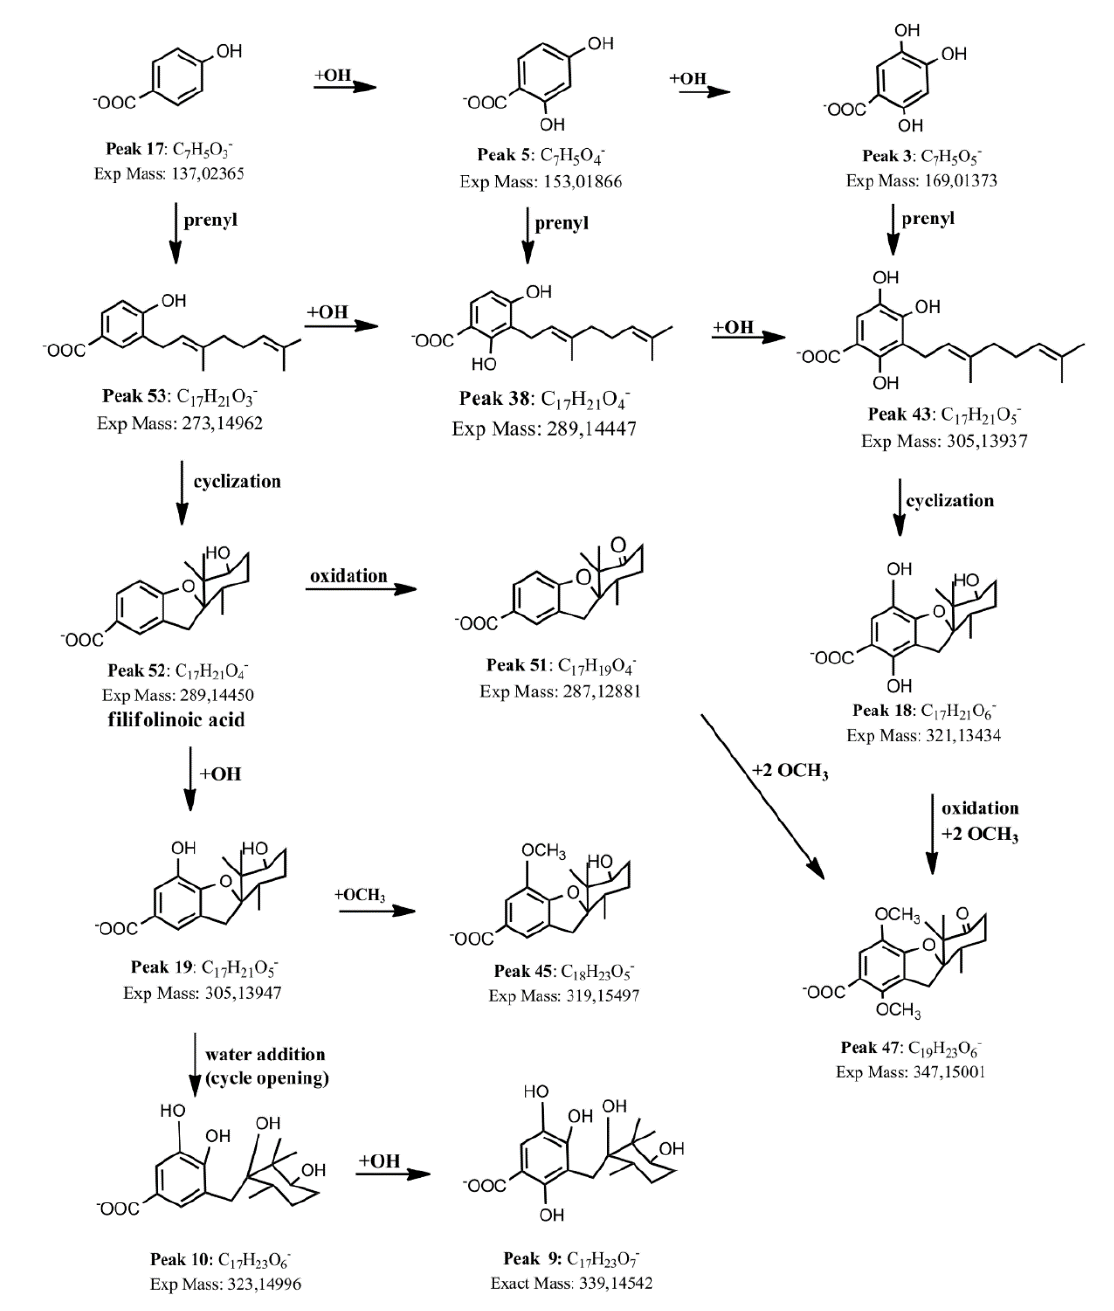
Figure 3. Proposed biosynthetic pathway for the benzoic acid derivatives detected in H. taltalense.